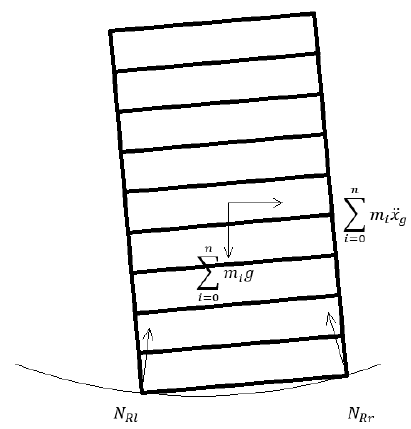
Figure 6. Force sketch of the isolation system equipped with SLDRFPB.